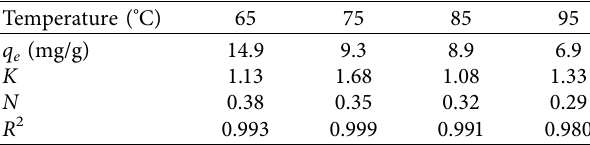
Table 3: The parameters of Bangham model of Figure 6(b).